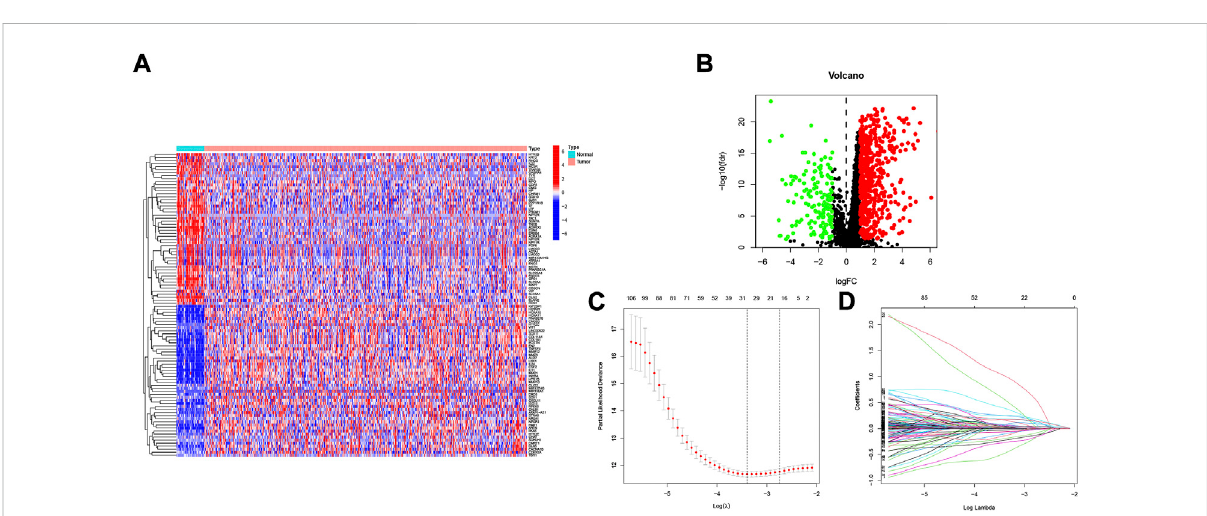
FIGURE 1 Work fl ow of the study.